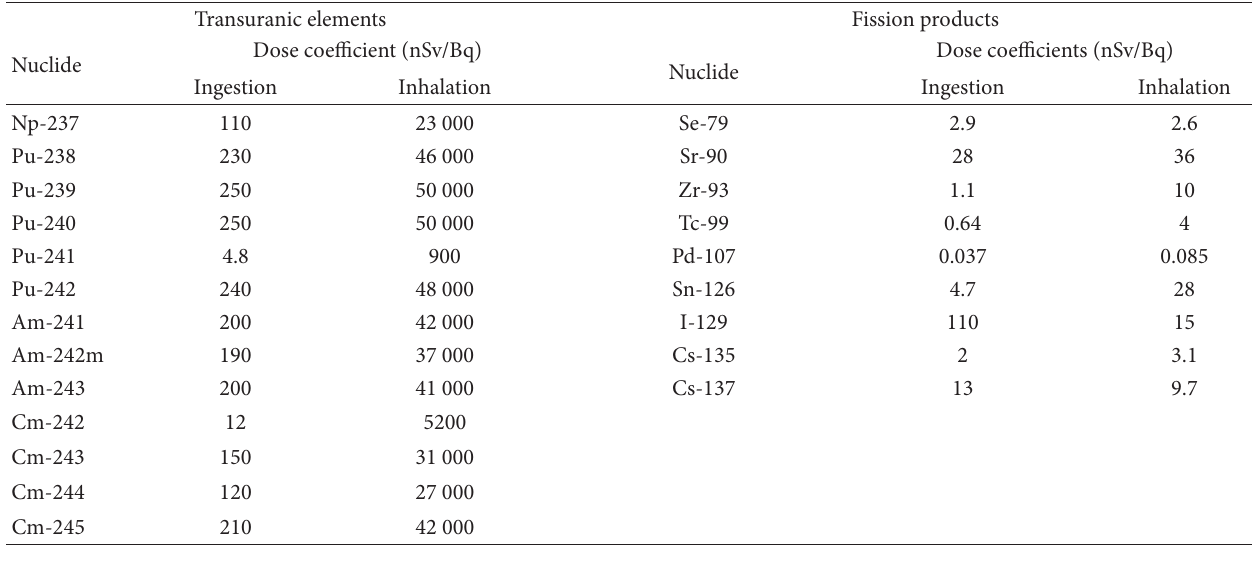
T 7: Dose coefficients (adult humans) for intake by ingestion and inhalation for important nuclides present in the German spent fuel legacy.